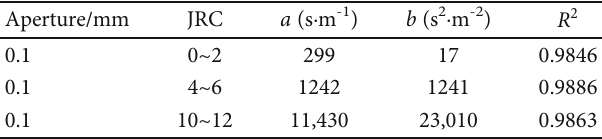
Table 3: Fitting results of Forchheimer equation of rough fracture under di ff erent JRC .